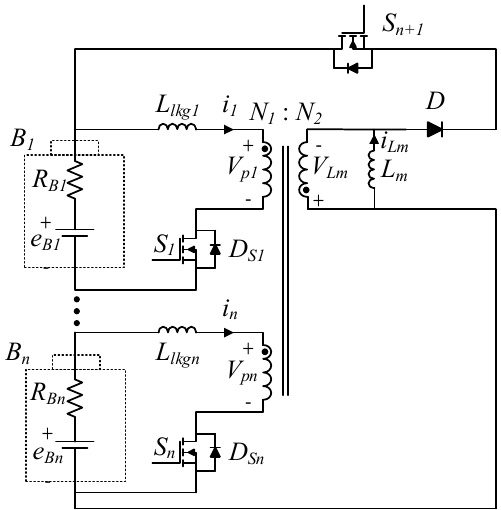
Figure 4. Voltage sensorless balancing method.